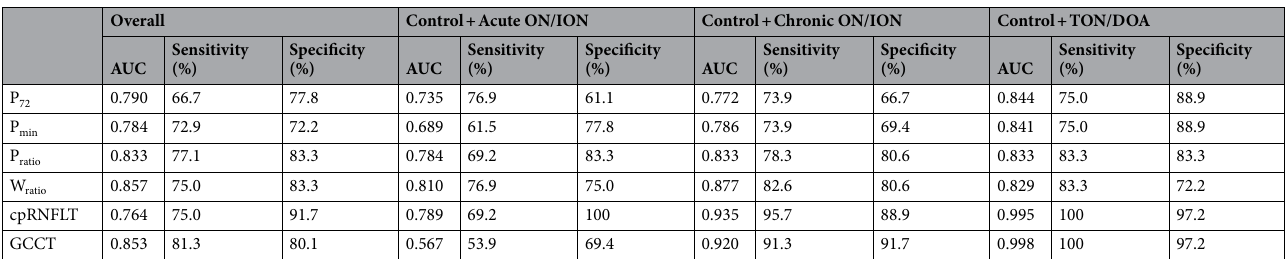
Table 4. Comparison of diagnostic abilities of PhNRs and OCT in optic nerve disorders. cpRNFLT, circumpapillary retinal nerve fiber layer thickness; GCCT, ganglion cell complex thickness; AUC, area under the curve; ON, optic neuritis; ION, ischemic optic neuropathy; TON, traumatic optic neuropathy; DOA, dominant optic